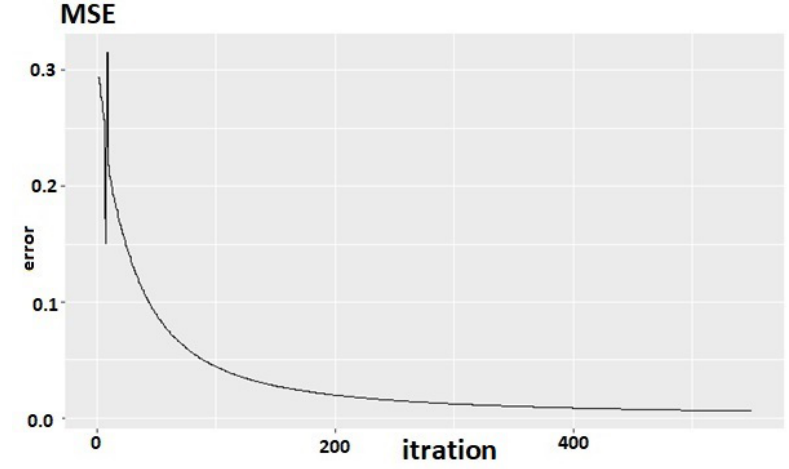
Figure 11. Fuzzy network 1—learning process.